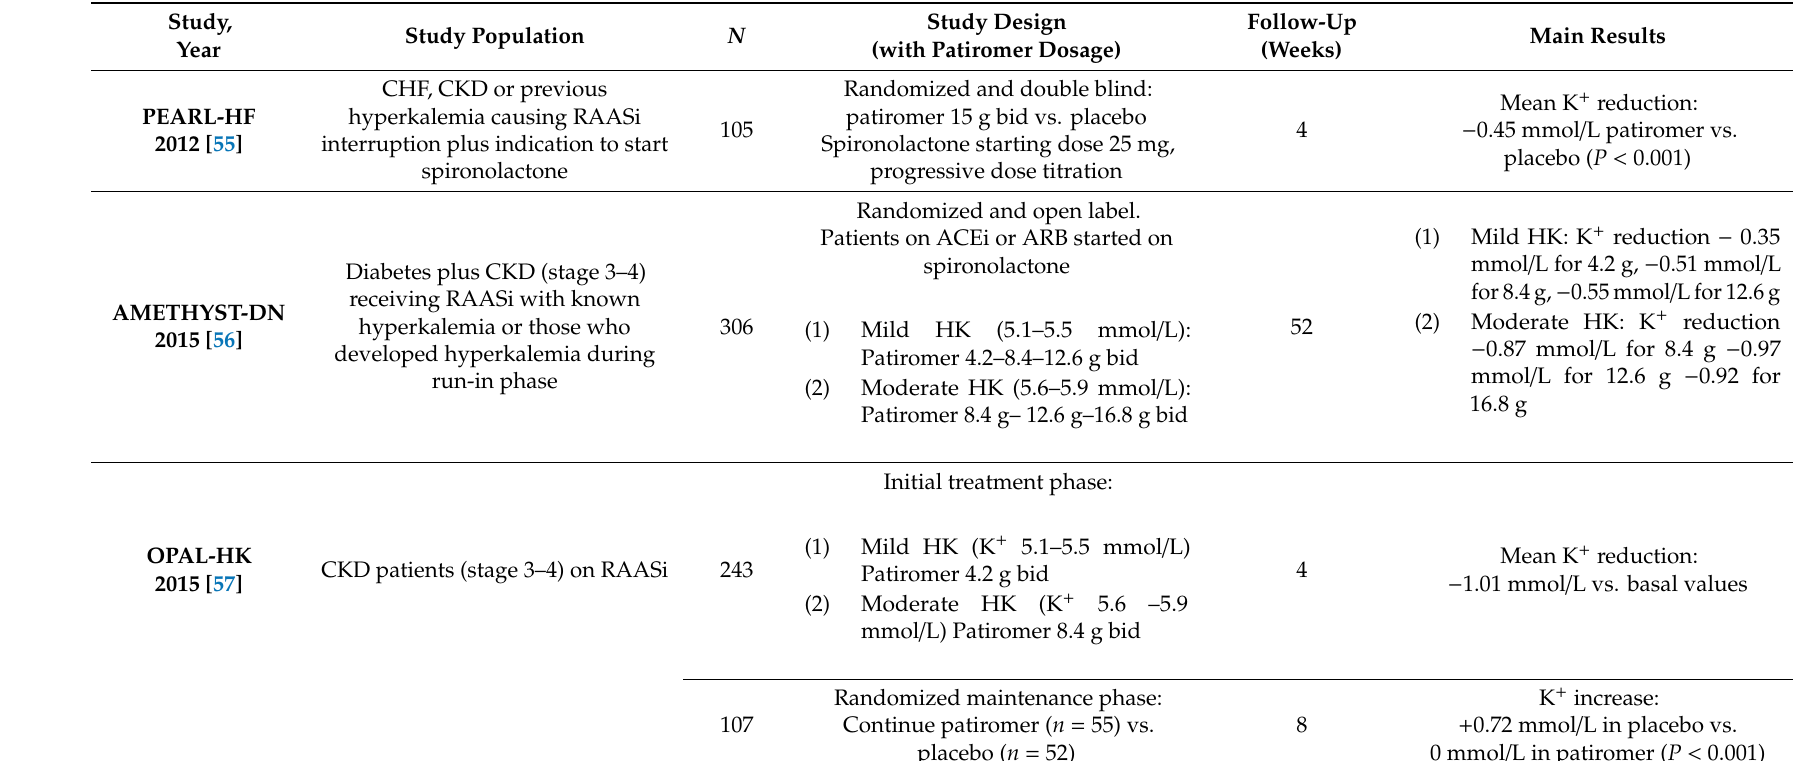
Table 1. Main clinical trials evaluating use of patiromer for chronic